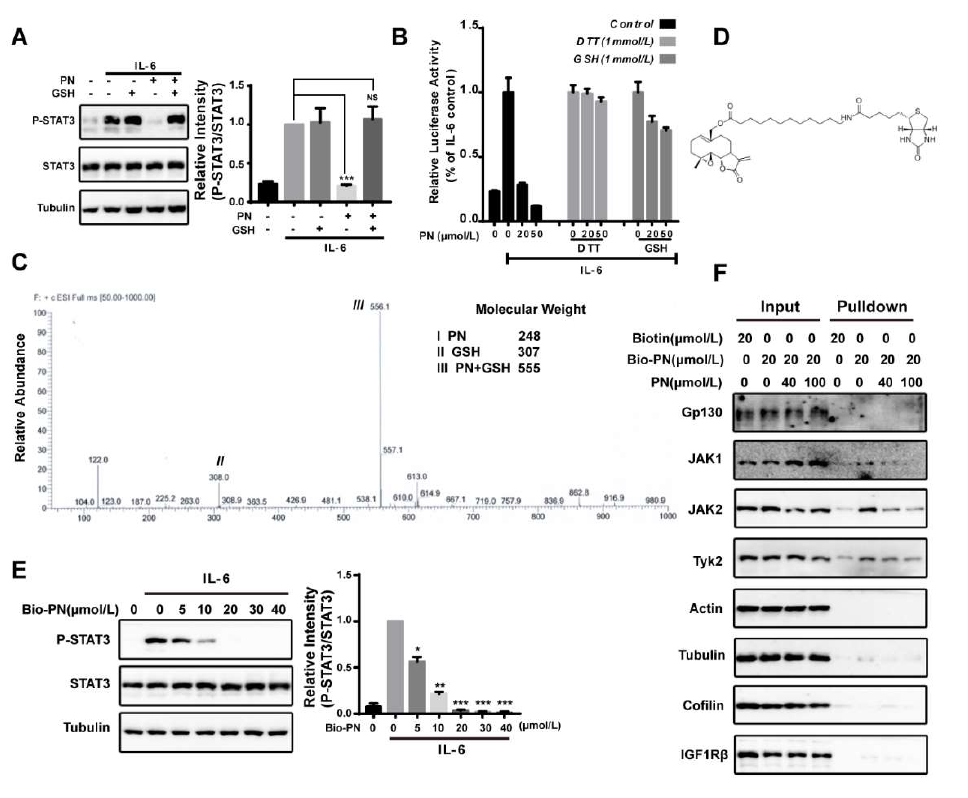
Figure 2. Parthenolide was a pan-JAK covalent inhibitor. ( A ) GSH blocking assay. MDA-MB-231 cells were treated with GSH (1 mmol/L), PN (20 μmol/L) or their incubation products for 1 h and then stimulated with IL-6 (10 ng/mL) for 10 min. Cell lysates were processed for Western blot analysis. ( B ) GSH and DTT blocking assay. HepG2/STAT3 cells were treated with GSH, DTT, PN or their